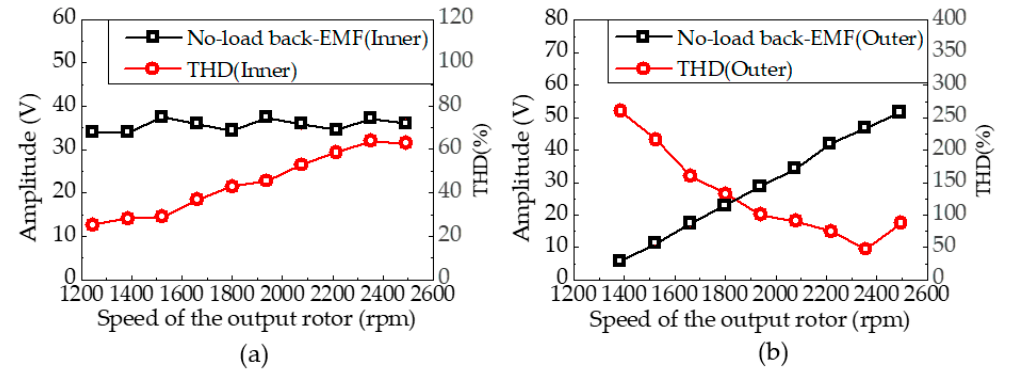
Figure 10. No-load back-EMF characteristics with the variation of the speed of the output rotor in the inner and outer windings: ( a ) Fundamental component and THD in the inner winding; ( b ) Fundamental component and THD in the outer